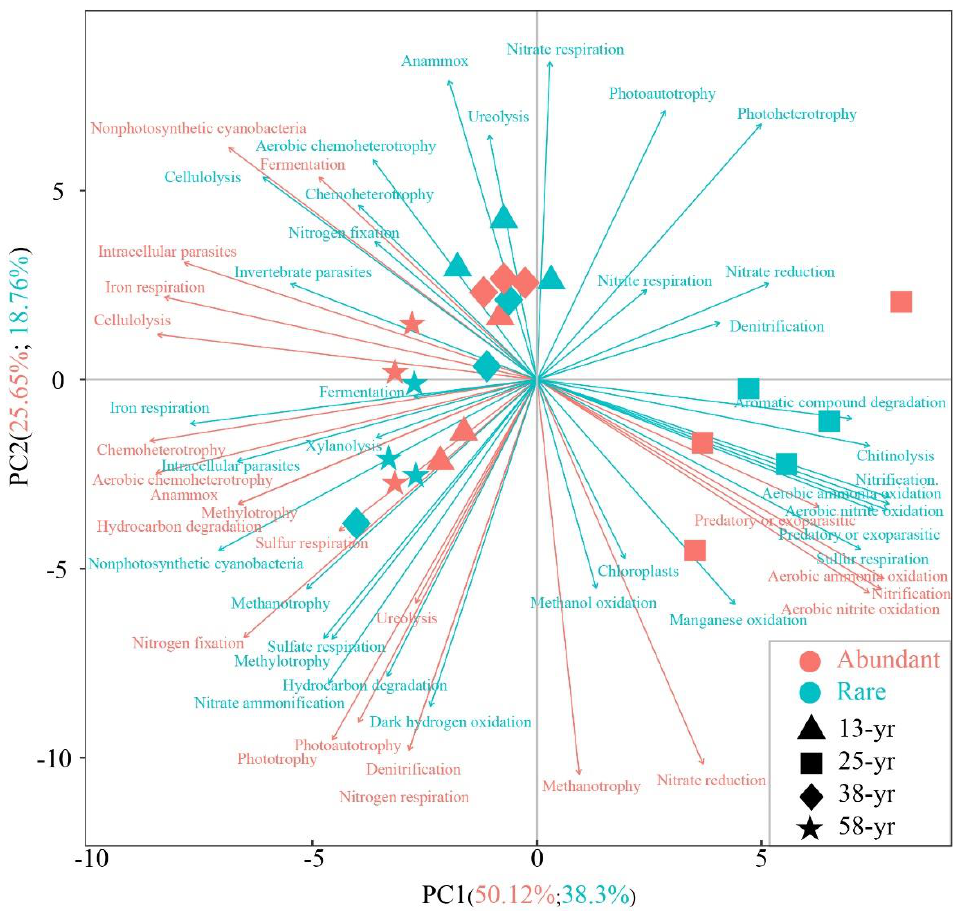
Figure 4. Principal component analysis of the functional OTU richness of abundant and rare bacterial taxa during P. massoniana development .